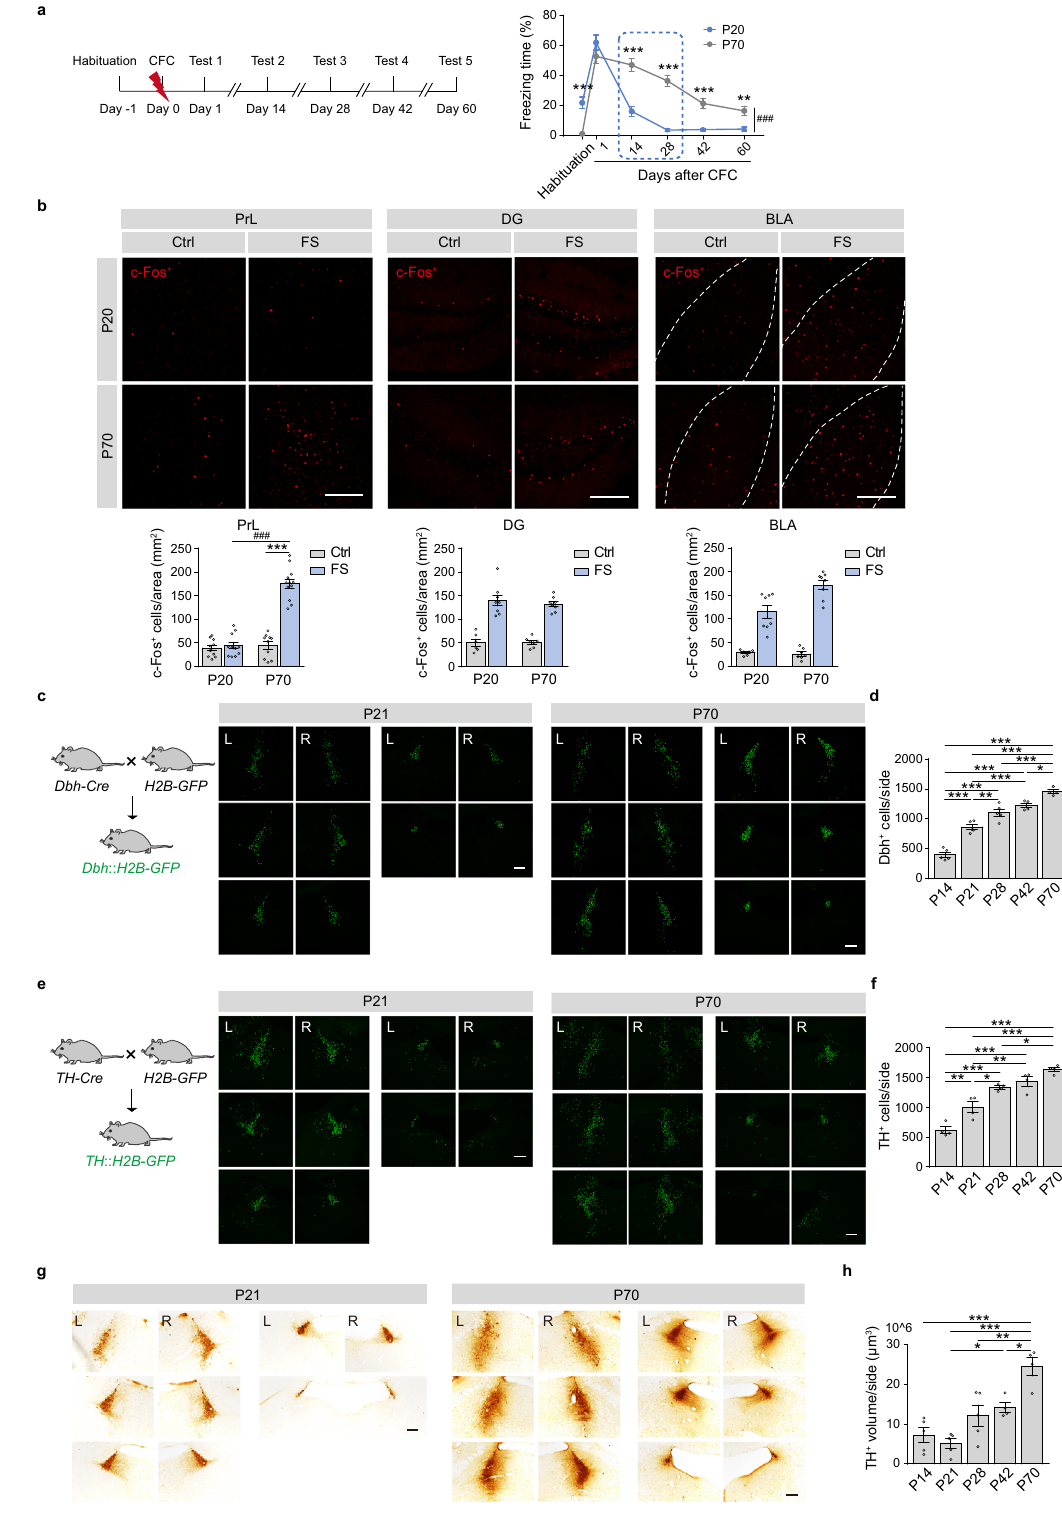
Fig. 6 | Juvenile mice show defects in remote memory storage and immature LC/NE system. a Experimental scheme. Fear conditioning was carried out in juvenile(P20)andadult(P70)mice,andmemorytestswereperformed1,14,28,42, and 60 days later. b Representative images and statistical graphs for c-Fos + cell counts in the PrL, DG, and BLA. c , e Representative images (every 90 μ m) of H2B- GFP + cells in the LC of Dbh::H2B-GFP mice and TH::H2B-GFP mice (P21 and P70).